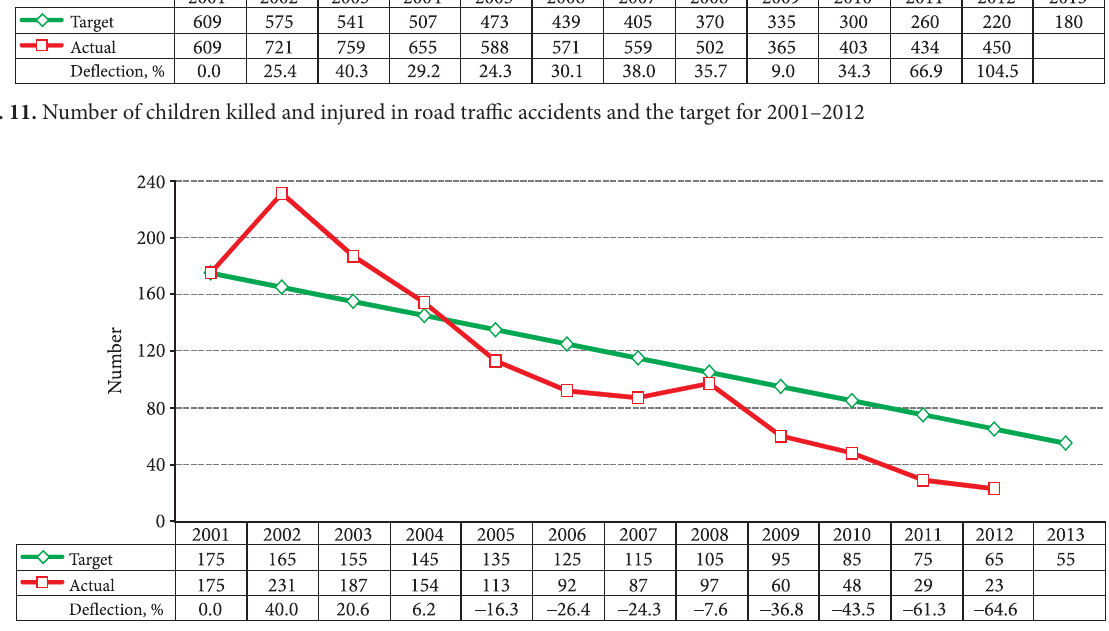
Fig. 12. Number of killed because of violation of permitted speed limits and the target for 2001–2012